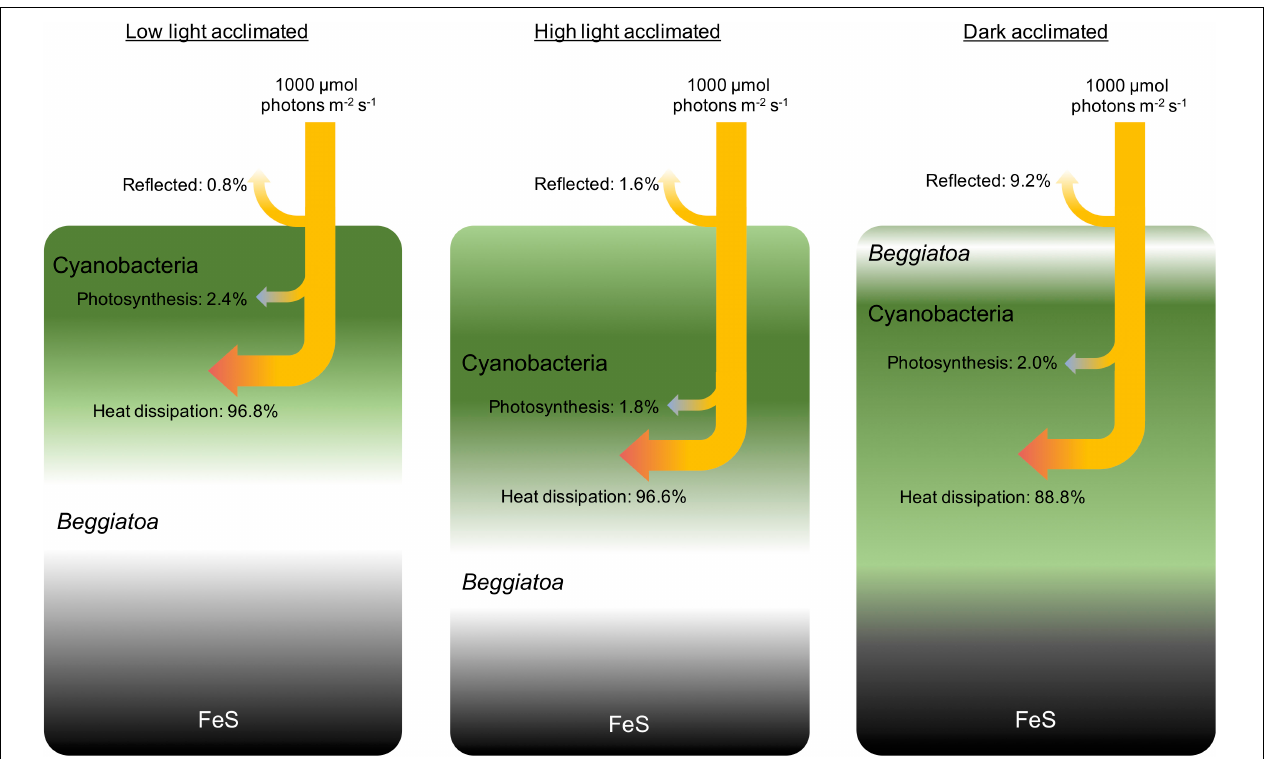
FIGURE 1 | Conceptual drawing of the biomass distribution during different light acclimation scenarios and the corresponding radiative energy budgets of the entire photic zone measured under an incident photon irradiance of 1000 µ mol photons m − 2 s − 1 . The surface layers of the microbial mat were dominated by dense populations of motile cyanobacteria ( Microcoleus sp. and other filamentous species) and filamentous sulfide oxidizing bacteria ( Beggiatoa spp.). Beneath the narrow photic zone, a dark FeS-containing sediment layer was present. In low light, the upper layers became oxidized driving the O 2 -H 2 S interface and thus Beggiatoa deeper into the mat, while the motile cyanobacteria moved toward the mat surface under non-inhibitory light levels. In high light, a larger part of the biofilm is oxidized, Beggiatoa moved further down, while motile cyanobacteria in the top layers started to move downwards to avoid high photoinhibitory light levels at the microbial mat surface. In darkness, the entire mat became anoxic and the Beggiatoa moved to the mat surface forming a white layer on top of the cyanobacteria, to avoid the high levels of H 2 S and remain at the O 2 -H 2 S interface (Preisler et al., 2007), whereas the cyanobacteria remained in a dense layer